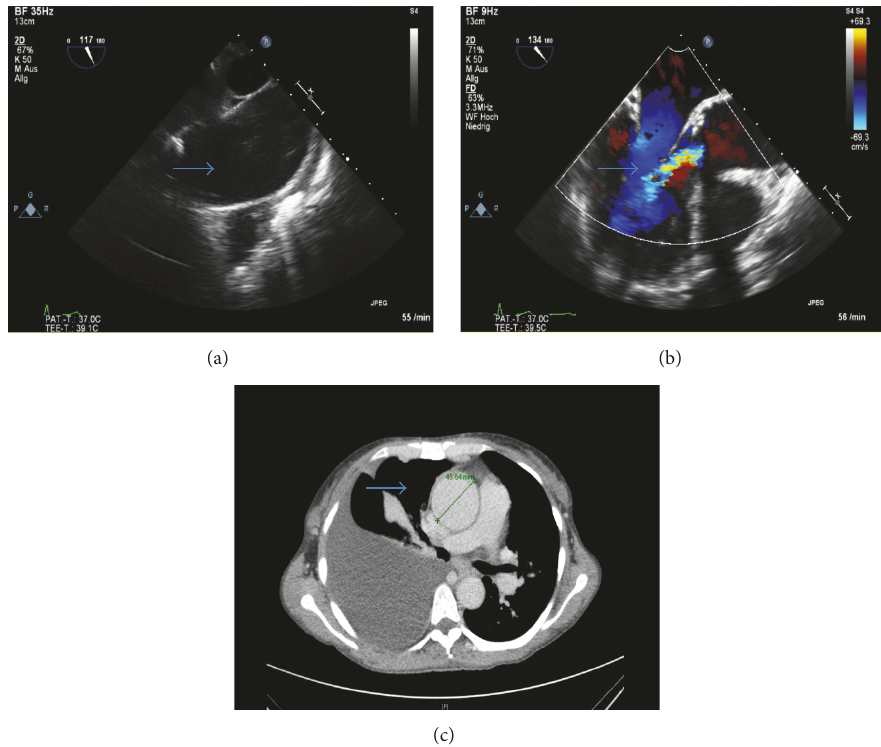
Figure 1: Aneurysm of ascending aorta ((a), blue arrow) and insufficiency of the aortic valve ((b), blue arrow, transesophageal echocardiography). Ascendens aneurysm was evaluated using CT-scan ((c), blue arrow, distal part of the aorta ascendens above the sinus valsalvae, early arterial